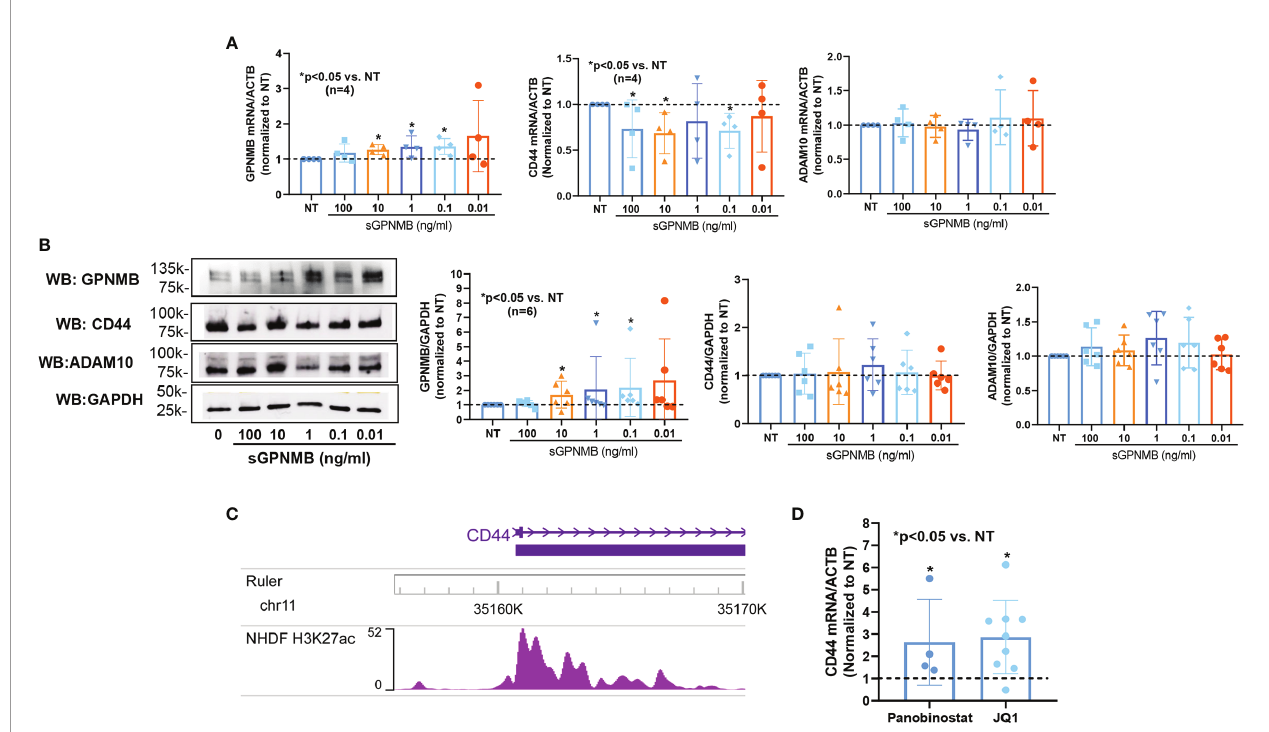
FIGURE 4 | Mechanisms involved in GPNMB and CD44 expression in dcSSc fi broblasts. (A) sGPNMB signi fi cantly induced GPNMB expression in dcSSc fi broblasts and downregulated CD44 expression. sGPNMB had minimal effect on ADAM10 expression. (B) At the protein level, sGPNMB induced GPNMB at 0.1, 1, and 10 ng/ml while it had no effect on CD44 and ADAM10. (C) Genome browser track of the CD44 locus along with ChIP-seq data for H3K27ac in normal human dermal fi broblasts (NHDF) generated by the ENCODE project. (D) CD44 levels were elevated after dcSSc fi broblasts were treated with HDAC inhibitor Panobinostat or histone reader inhibitor JQ1. n=number of subjects. Results are expressed as mean +/- SD and p < 0.05 was considered signi fi